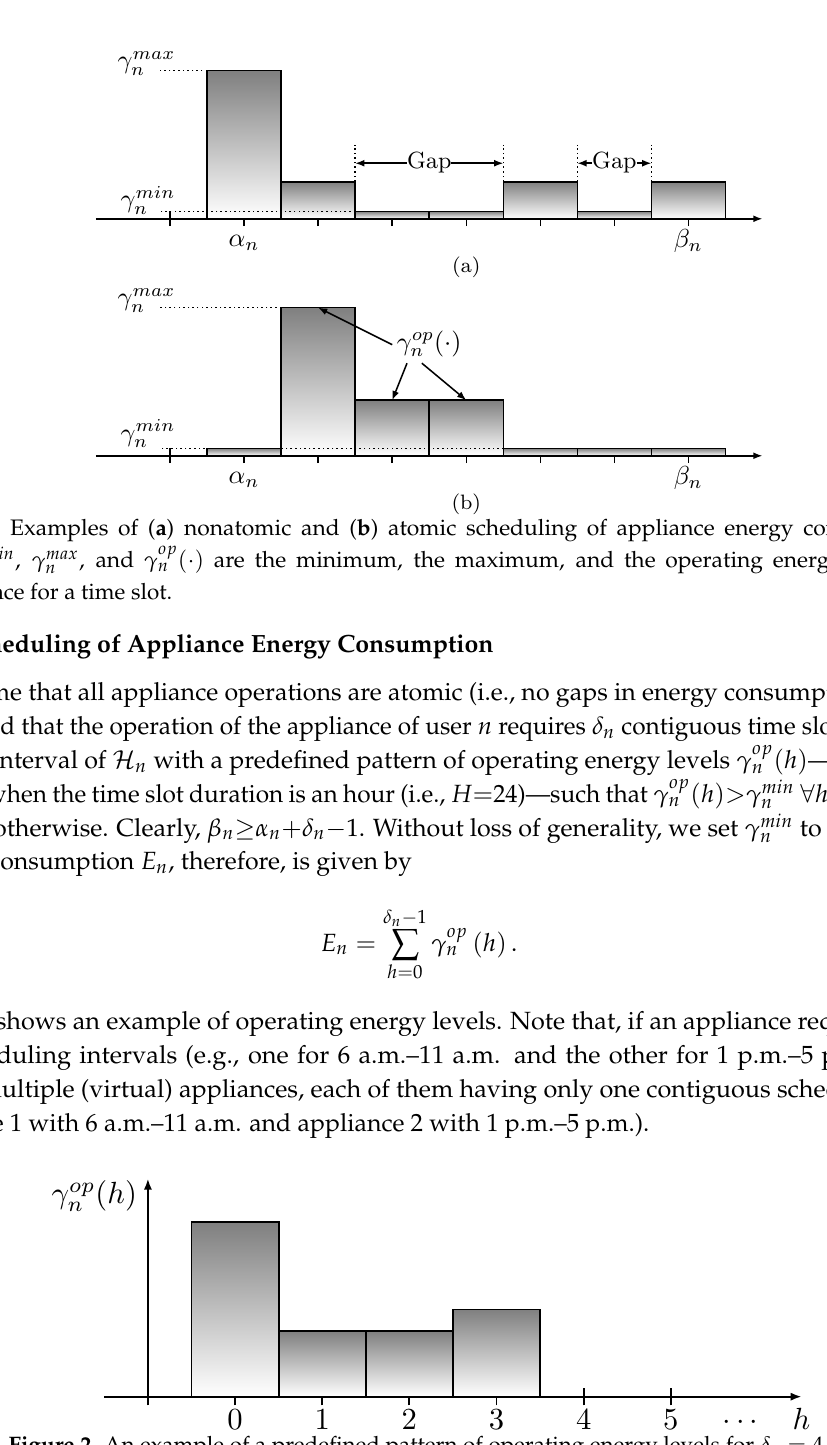
Figure 2. An example of a predefined pattern of operating energy levels for δ n =